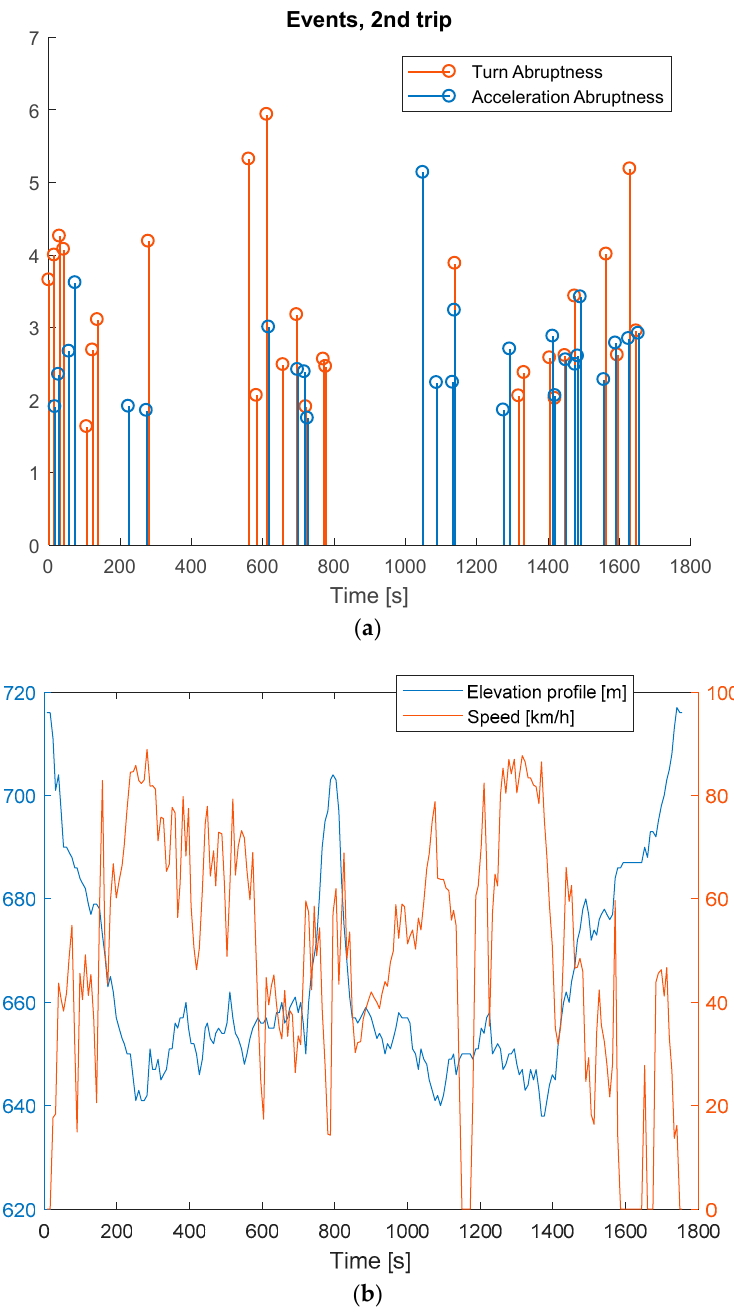
Figure 12. ( a ) Detected events during Trip #2 ( b ) Speed and elevation profiles during Trip #2.